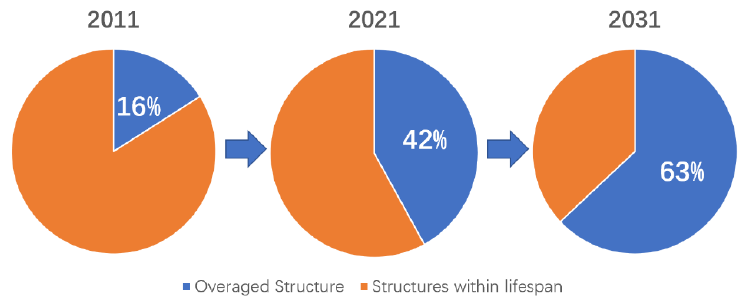
Figure 1. Changes in the ratio of overaged concrete structures in Japan by decade.